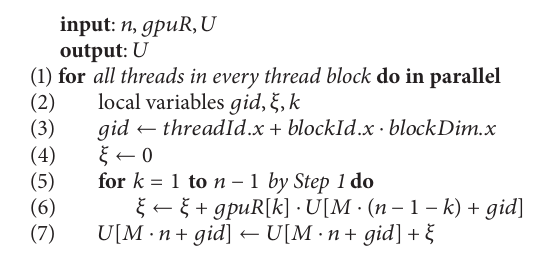
Algorithm 4: Optimized CUDA kernel for constant vector multi- plication and vector-vector